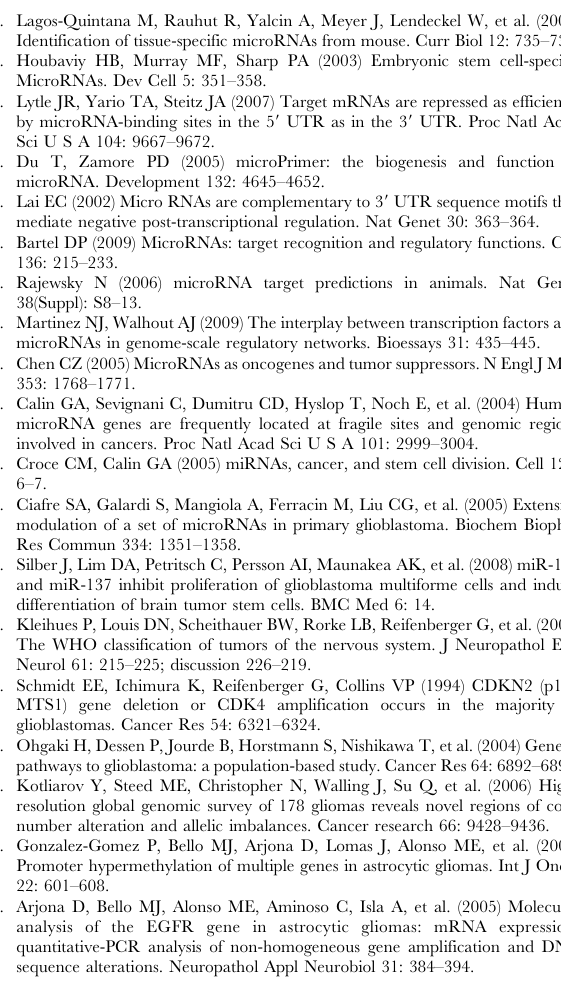
Table S3 List of 626 predicted associations between mRNA and miR (P , 0.05). We indicated if the underlying miRs and mRNAs are over ( X , lg 2 fold change . 1) or under ( Y , lg 2 fold change ,2 1) expressed in GBMs.